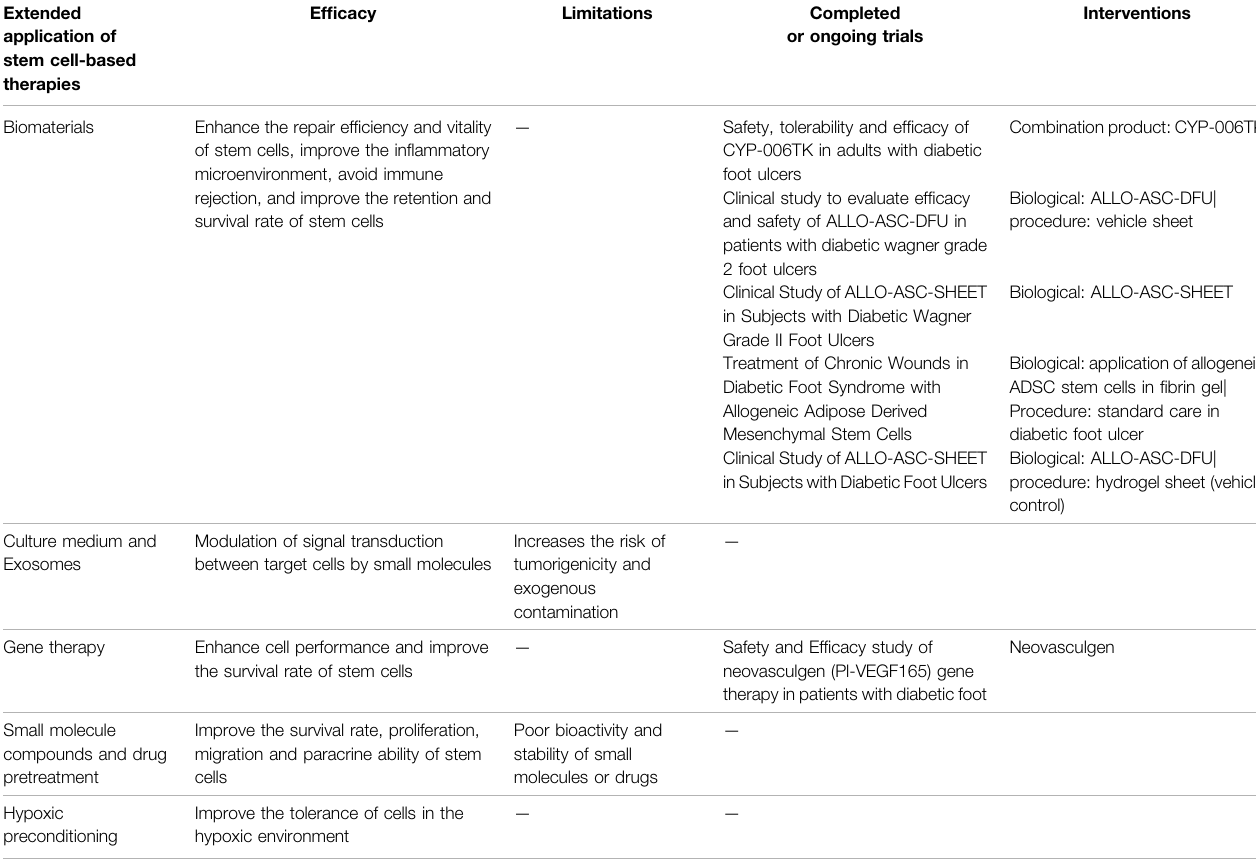
TABLE 2 | Documented ef fi cacy and limitations of extended application of stem cell-based therapies and brief summary of major trials for each modality. Extended application